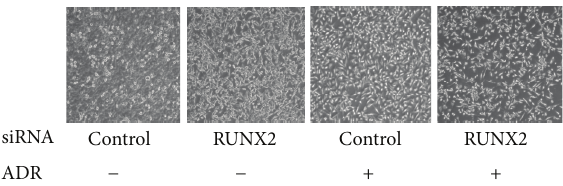
Figure 4: Knockdown of RUNX2 enhances ADR-mediated apop- toticcelldeathinU2OScells.U2OScellsweretransientlytransfected with control siRNA or with siRNA targeting RUNX2. Twenty-four hours after transfection, cells were exposed to ADR or left untreated. Twenty-four hours after ADR exposure, cells were observed by phase-contrast